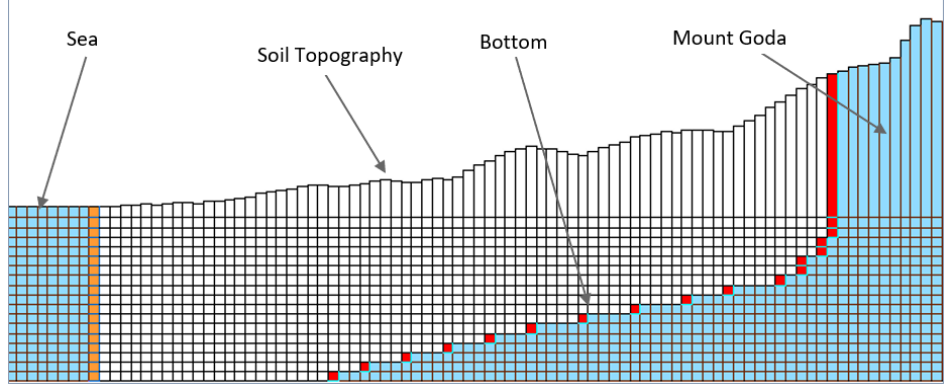
Figure 8. NS cross-section AA’ showing the discretization of the model. (Exaggerated vertical scale × 5).